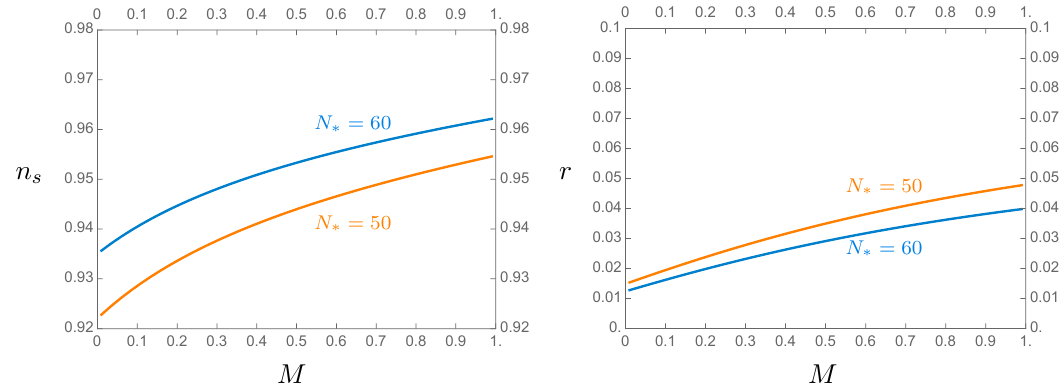
Figure 11 . Spectral index n s as a function of M in units of 10 16 GeV (left) and tensor-to-scalar ratio r as a function of M in units of 10 16 GeV (right) with a decay constant f (cid:24) (cid:24) 4 M Pl . The blue (orange) curve follows the evolution of the cosmological observables for N (cid:3) = 60 ( N (cid:3) = 50)